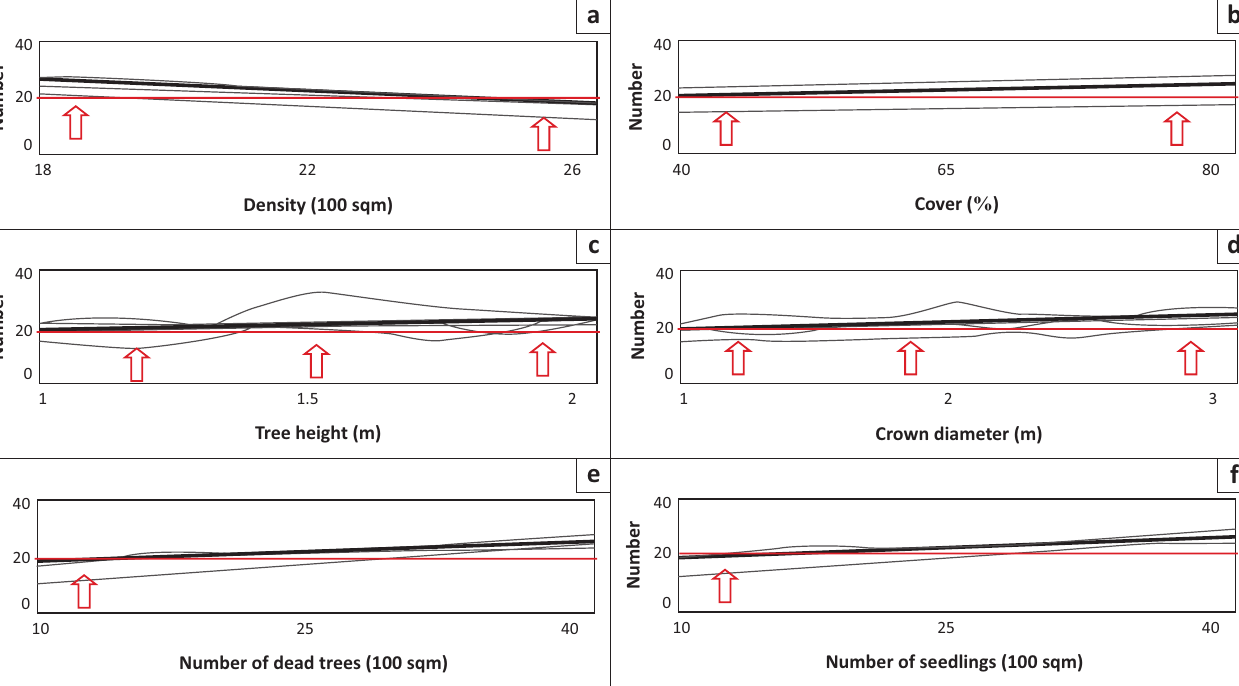
Red arrows = higher precision of uncertainty. FIGURE 8: Qurum Island demographic features sensitivity analysis (a) Density (100 m 2 ); (b) Cover ( % ); (c) Tree height (m); (d) Crown diameter (m); (e) Number of dead trees (100 m 2 ); (f) Number of seedlings (100 m 2 ); (g) Number of respiratory roots (100 m 2 ) and (h) Average height of respiratory roots